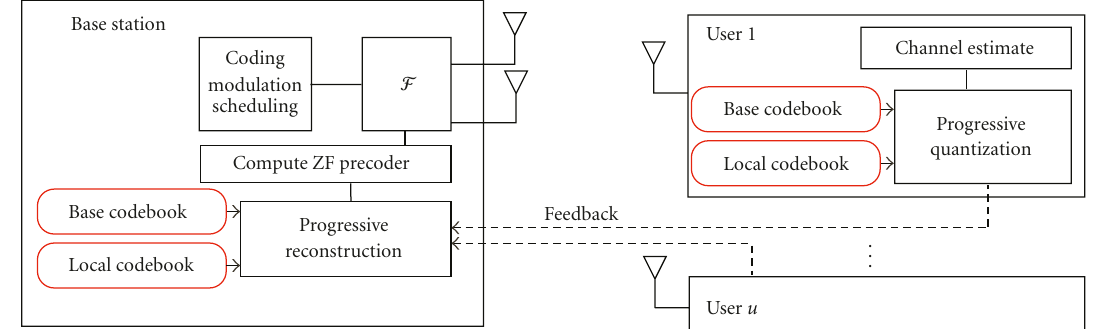
Figure 2: Illustration of a multiuser MIMO system with limited feedback beamforming. Progressive quantization is employed at the receiver while progressive reconstruction is used at the transmitter. A nonlocal base and a local codebook, both known to transmitter and receiver, are used in the progressive quantization and